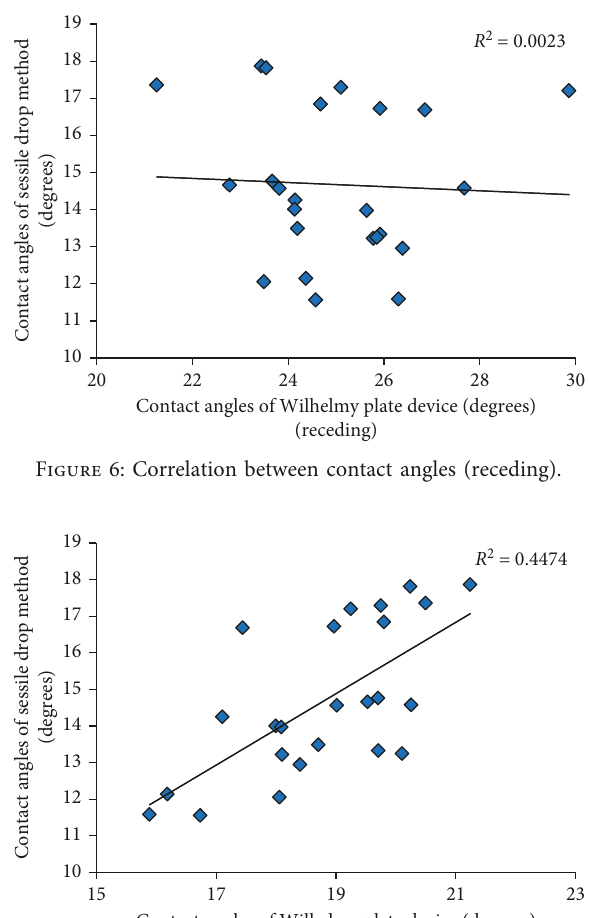
Contact angles of Wilhelmy plate device (degrees) (advancing) Figure 7: Correlation between contact angles (advancing).